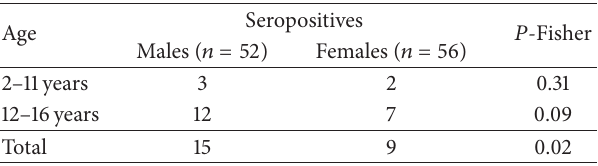
Table 1: Seroprevalence of Toxocara canis in boys and girls from 2 to 16years of